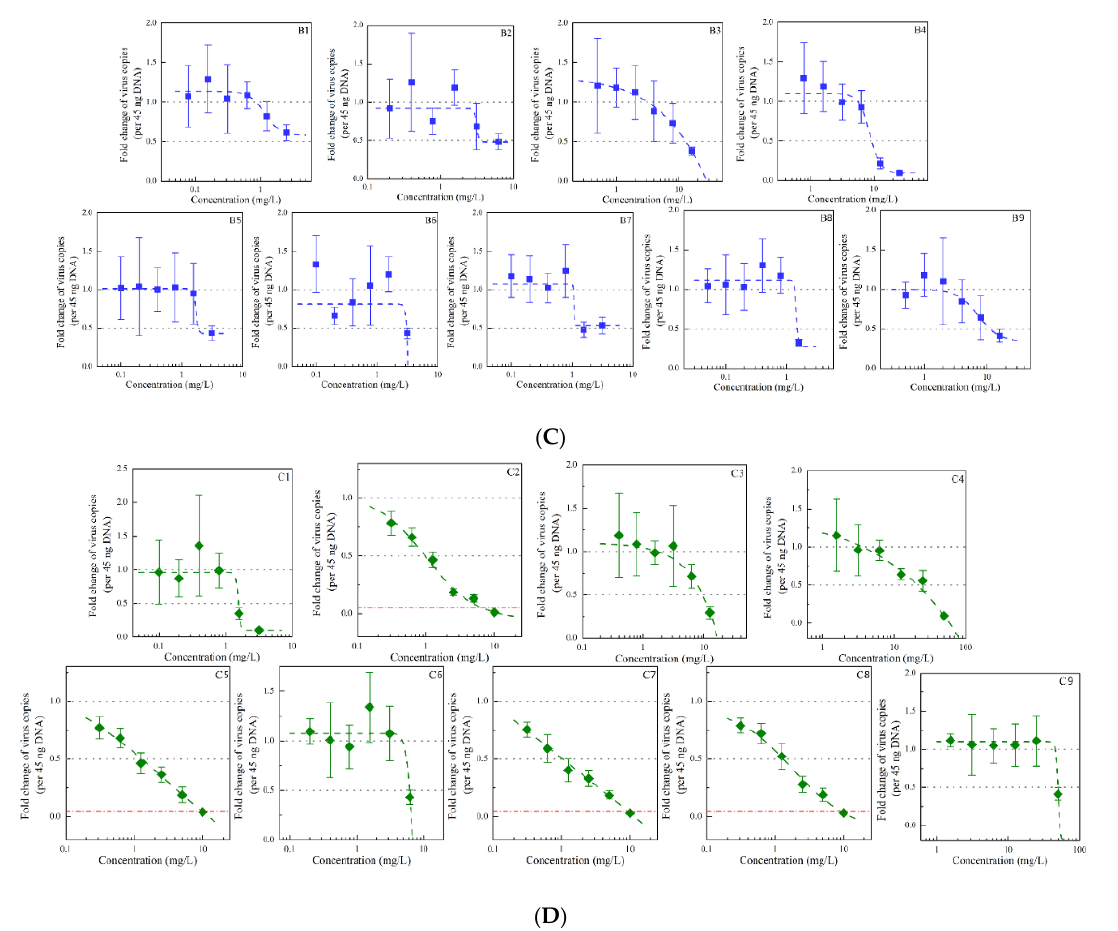
Figure 1. The percent inhibition of the 27 coumarin derivatives on white spot syndrome virus (WSSV) replication in shrimp larvae is shown. ( A ) Schematic diagram describing the workflow. ( B – D ) Six-point dose-response curves for antiviral activity of coumarins are examined. The percent inhibition on quantification on copy number of viral genome is analyzed by RT-qPCR. Each value is represented as the mean ± SD normalized to values for no treatment.